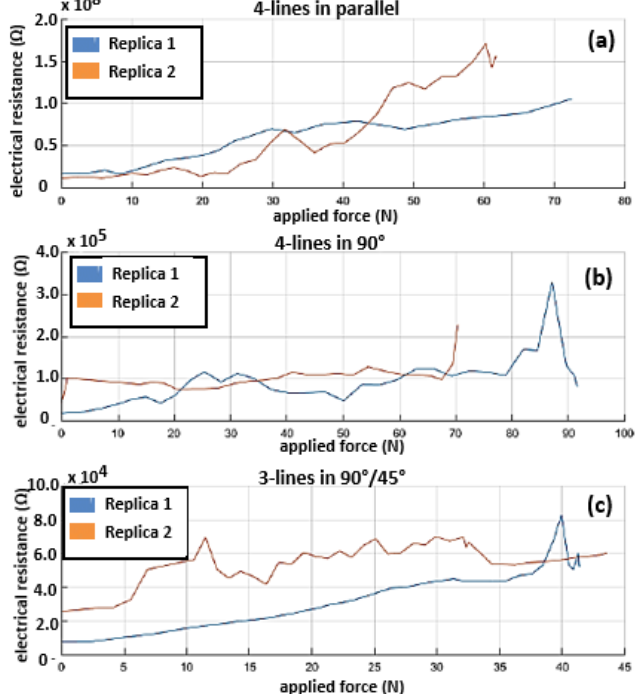
Figure 21. Tensile tests. Electrical resistance vs applied force for three manufactured MRE transducers shown in Figure 3. For each transducer, two tests were carried out (Replicas 1 and 2). ( a ) Four lines in parallel; ( b ) four lines in 90 ◦ ; and ( c ) three lines in 90 ◦ /45 ◦